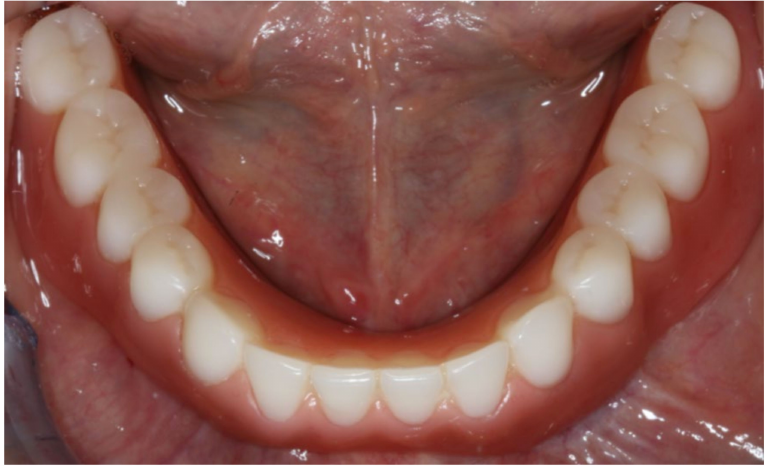
Figure 19. Inserted implant-supported overdenture in the lower jaw.